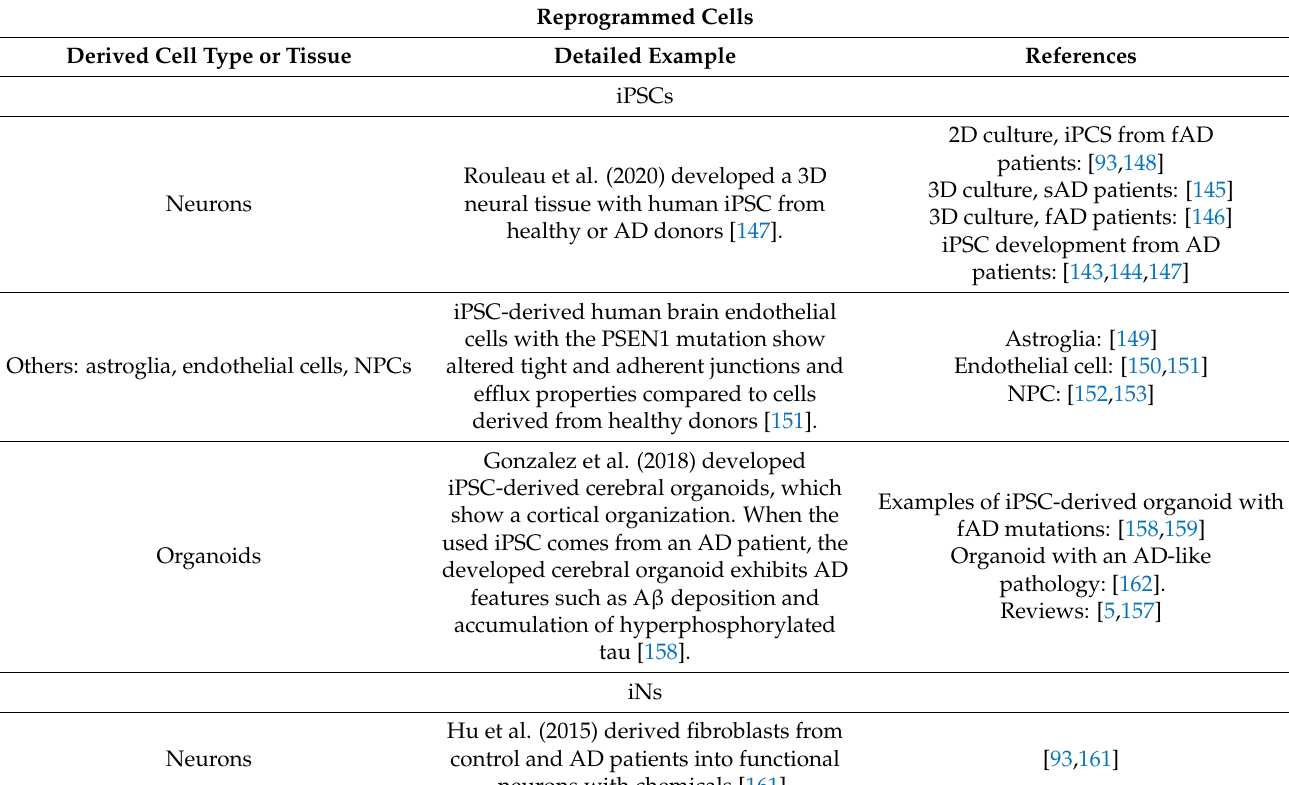
Table 4. Recent advances in AD reprogrammed cells. Reprogrammed